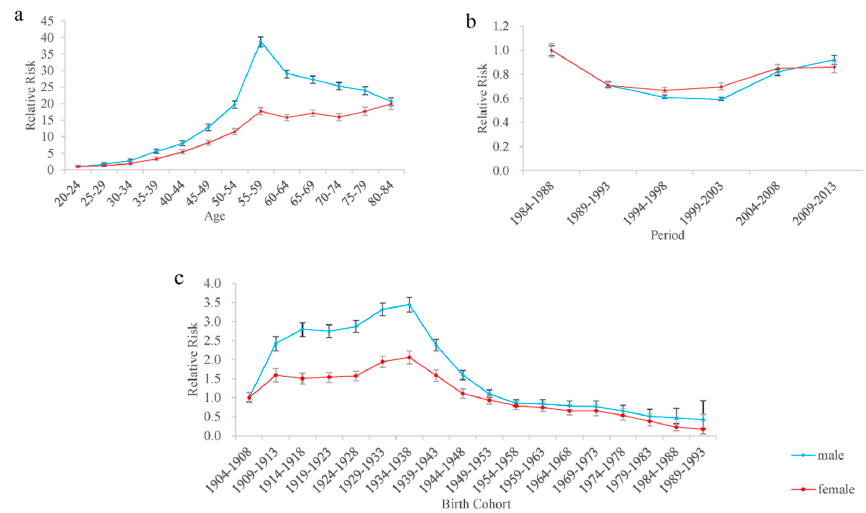
Figure 4. The relative risk and 95% confidence intervals of age, period, and cohort effects of cancer mortality risk among Macheng City residents, 1984–2013. ( a ) The relative risk and 95% confidence intervals of age effects of cancer mortality risk. ( b ) The relative risk and 95% confidence intervals of period effects of cancer mortality risk. ( c ) The relative risk and 95% confidence intervals of birth cohort effects of cancer mortality